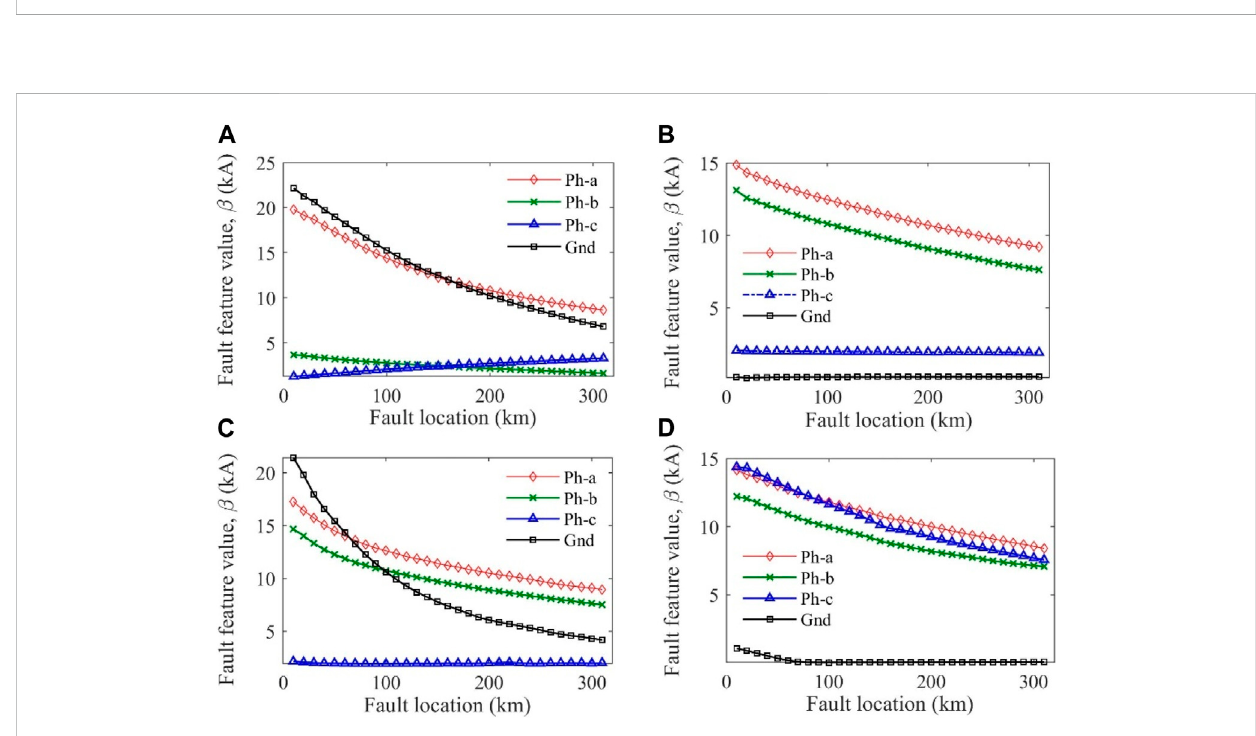
FIGURE 6 Demonstration of the variation of fault feature β with fault locations for (A) ag-fault, (B) ab-fault, (C) abg-fault, and (D)